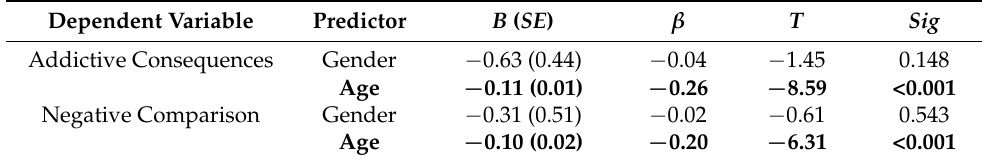
Table 4. Regression Equation Predicting the Level of Problematic SNS use.